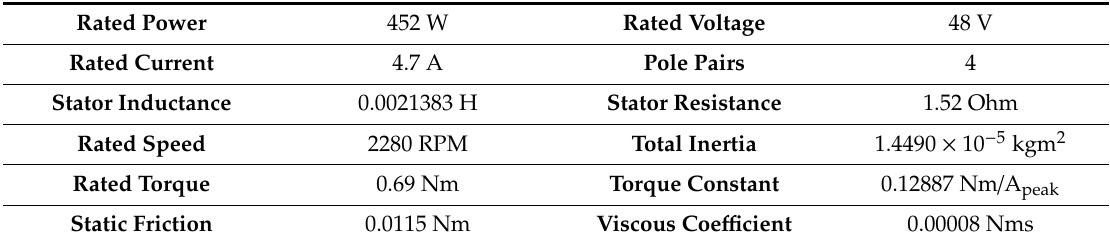
Table 1. Specification of the PMSM.